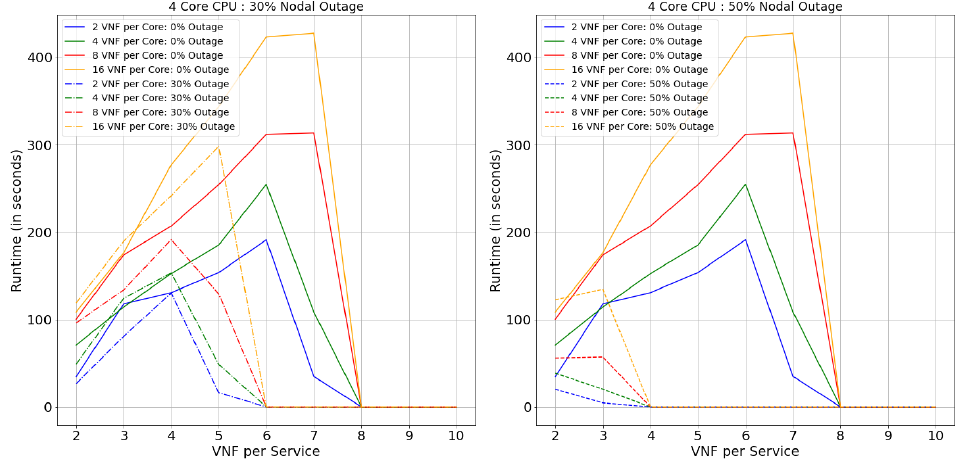
Figure 22. Runtime: Netrail topology with nodal outage—4 core